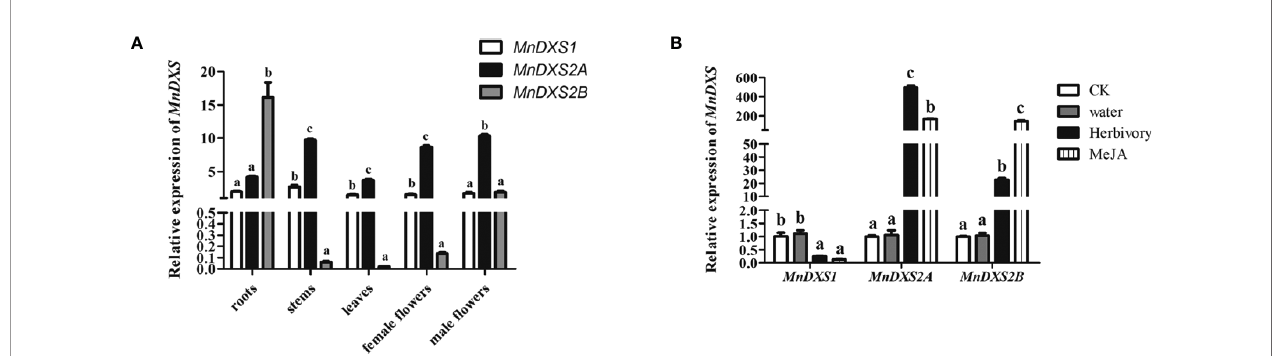
FIGURE 4 | Relative MnDXS expression levels in various tissues and in response to stress treatments based on a qRT-PCR assay. The Morus notabilis CTR9 gene was used as the internal control to normalize the expression levels. (A) Relative MnDXS1 , MnDXS2A , and MnDXS2B expression levels in the roots, stems, leaves, female fl owers, and male fl owers. (B) Relative MnDXS expression levels in leaves in response to silkworm feeding, MeJA and water. Data are presented as the mean ± standard error the mean of three replicates. The analysis of signi fi cant differences was conducted for each gene. CK stands for control without any treatment. Different letters above bars represent signi fi cant differences (p < 0.05) as determined with the one-way Duncan ’ s test.